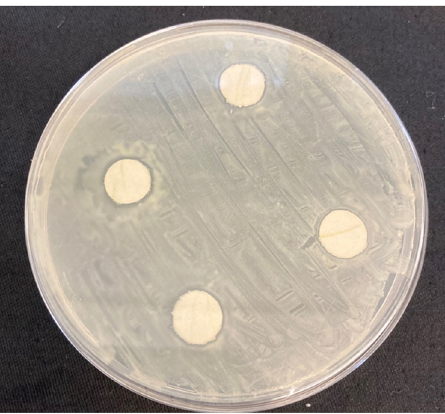
Figure 2: Results of the E. coli inhibition